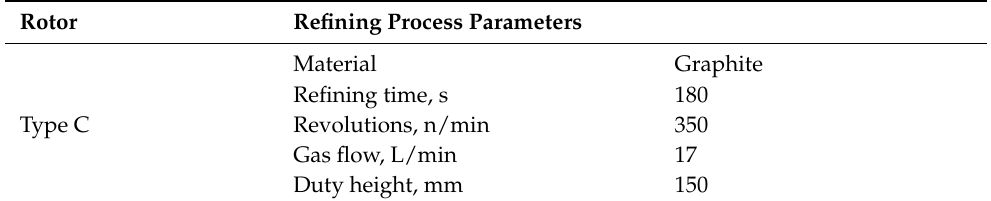
Table 5. Type C rotor — setting of refining technological parameters.